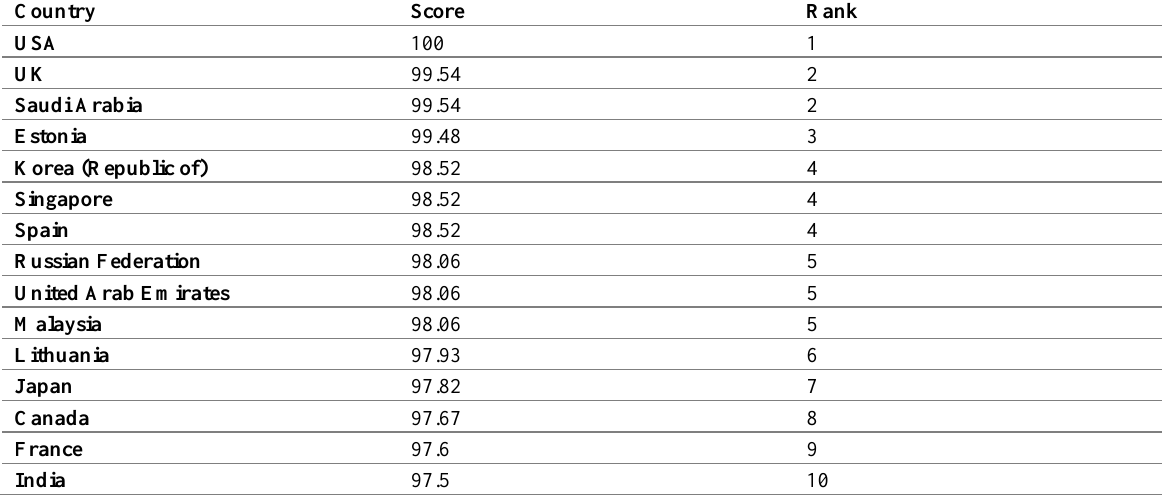
Table 4: Top 10 countries in Global Cybersecurity